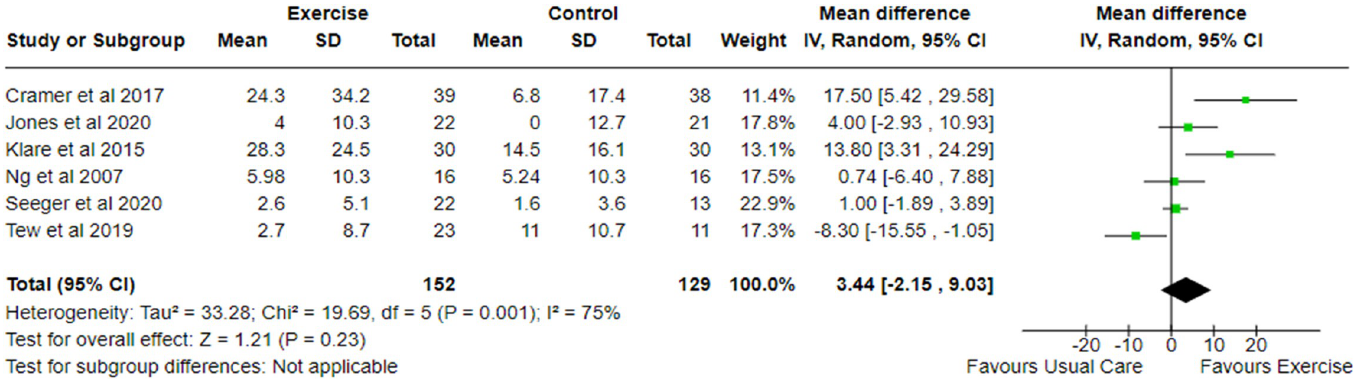
PLOS ONE | https://doi.org/10.1371/journal.pone.0278480 December1,